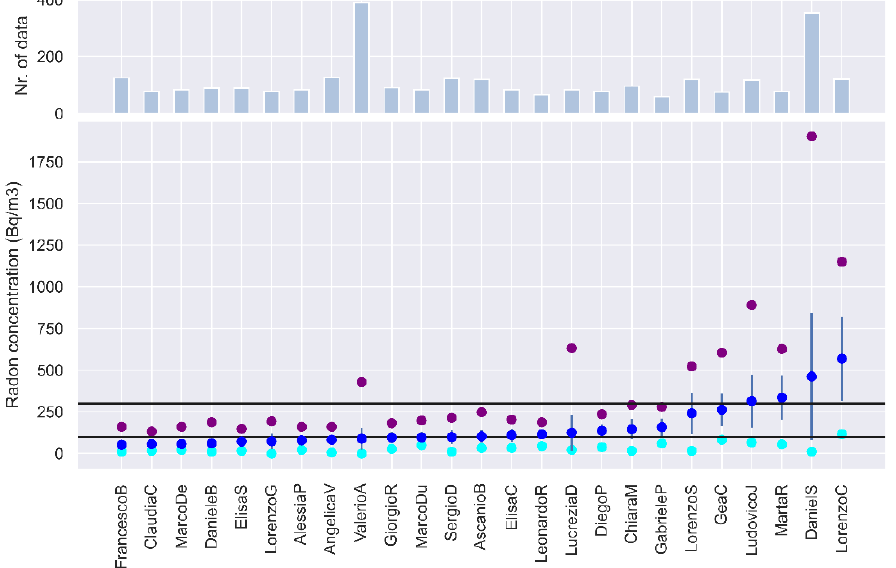
Figure 3. Mean (blue), minimum (cyan), and maximum (purple) values of radon concentration (Bq/m 3 ) for the time series recorded in the 25 apartments of Experiment 1. Error bars represent the standard deviation, and bars in the top panel indicate the number of collected data.